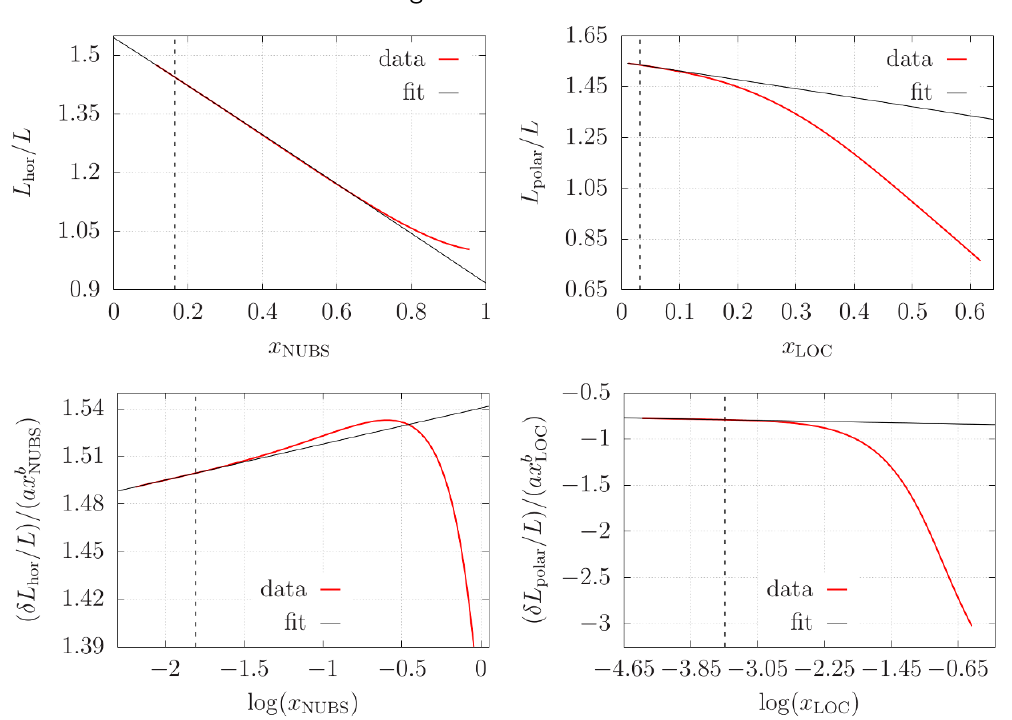
Figure 10 . Normalized horizon length and polar length as a function of x for NUBS and LOC respectively (top row). Data points left to the dashed vertical line are the ones used for the (cid:12)t. At the bottom row we represent (cid:14)L (cid:17) L (cid:0) L c normalized with respect to Lax b , as a function hor/polar of log x . In both cases the relation is